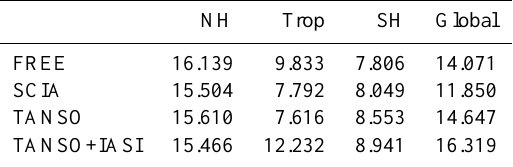
Table 2. Same as Table 1 but for the standard deviation.